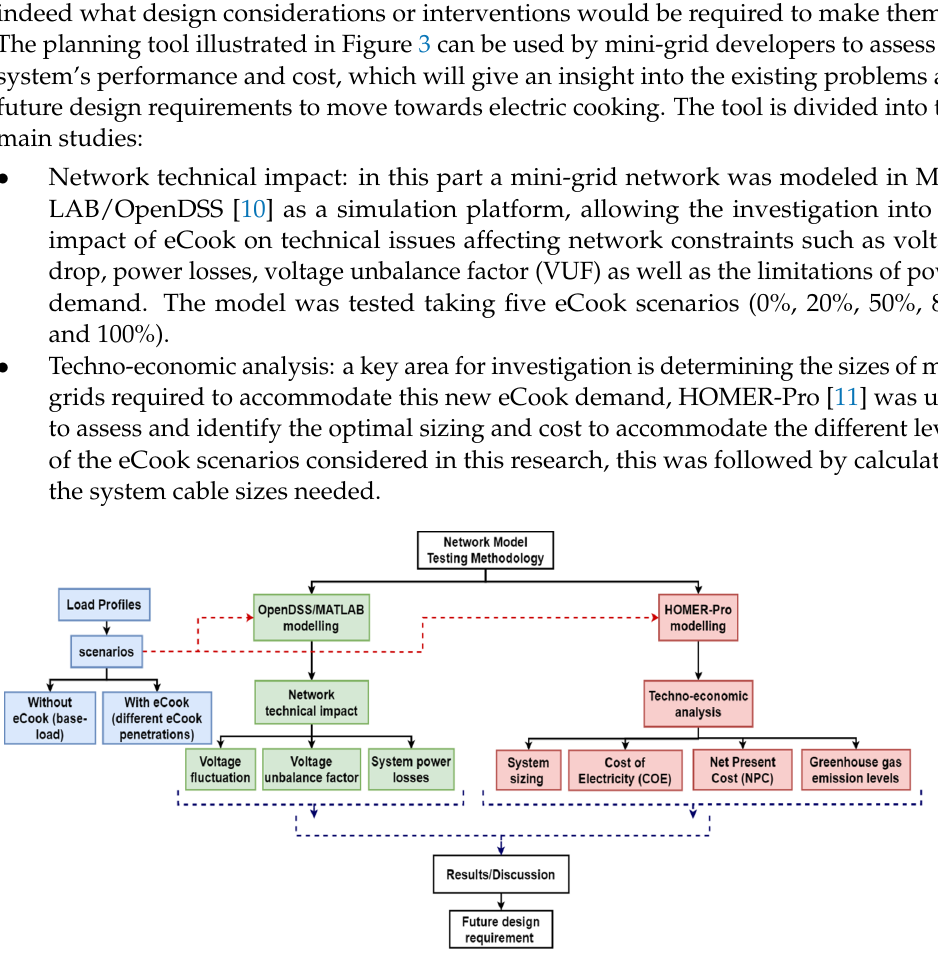
Figure 3. Network model testing methodology.